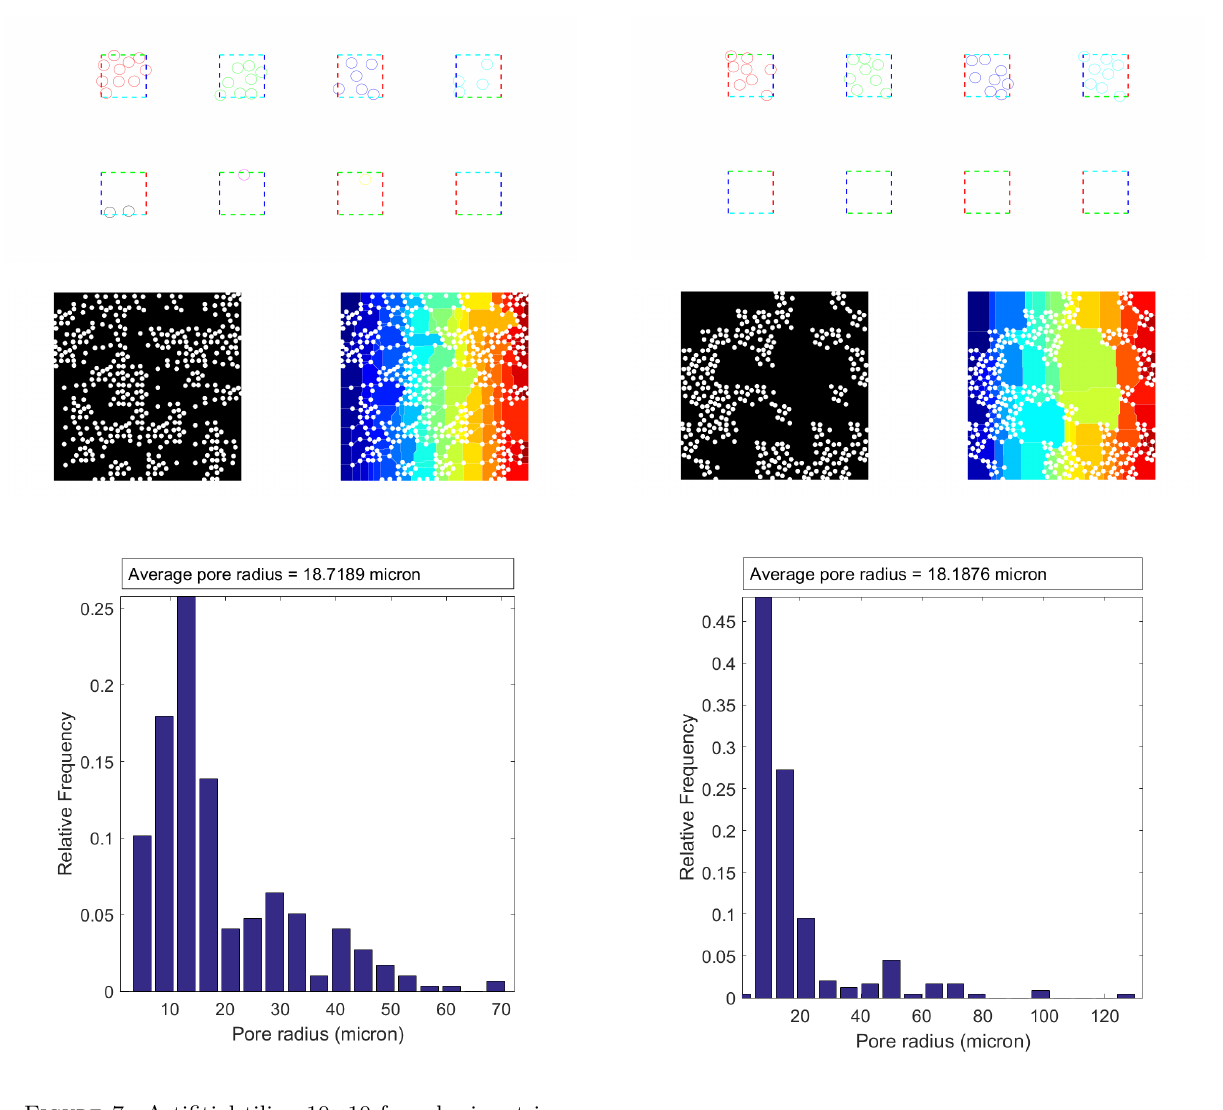
of tiles without any intervention in tiling algorithm.